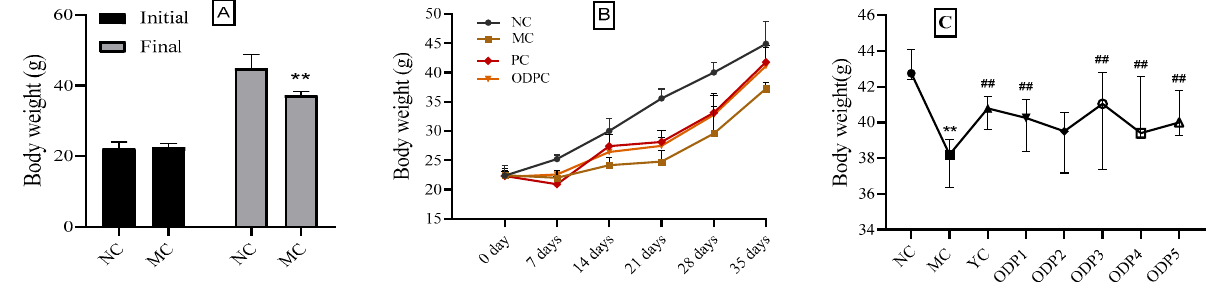
Figure 1. Changes in body weight gain in different groups of mice: ( A ) effects of cadmium exposure on the body weight of mice; ( B ) time–effect study of ODP; ( C ) dose–effect study of ODP. NC: normal control group, MC: CdCl 2 -treated group, YC: positive-treated group, ODPC: ODP-treated group. ODP1–5: ODP (50, 100, 200, 400, 600 mg/kg)-treated group. The presented values are x ± SD ( n = 6 for each group). * Compared with normal control group (NC group), ** p < 0.01; # compared with model control group (MC group), ## p < 0.01.